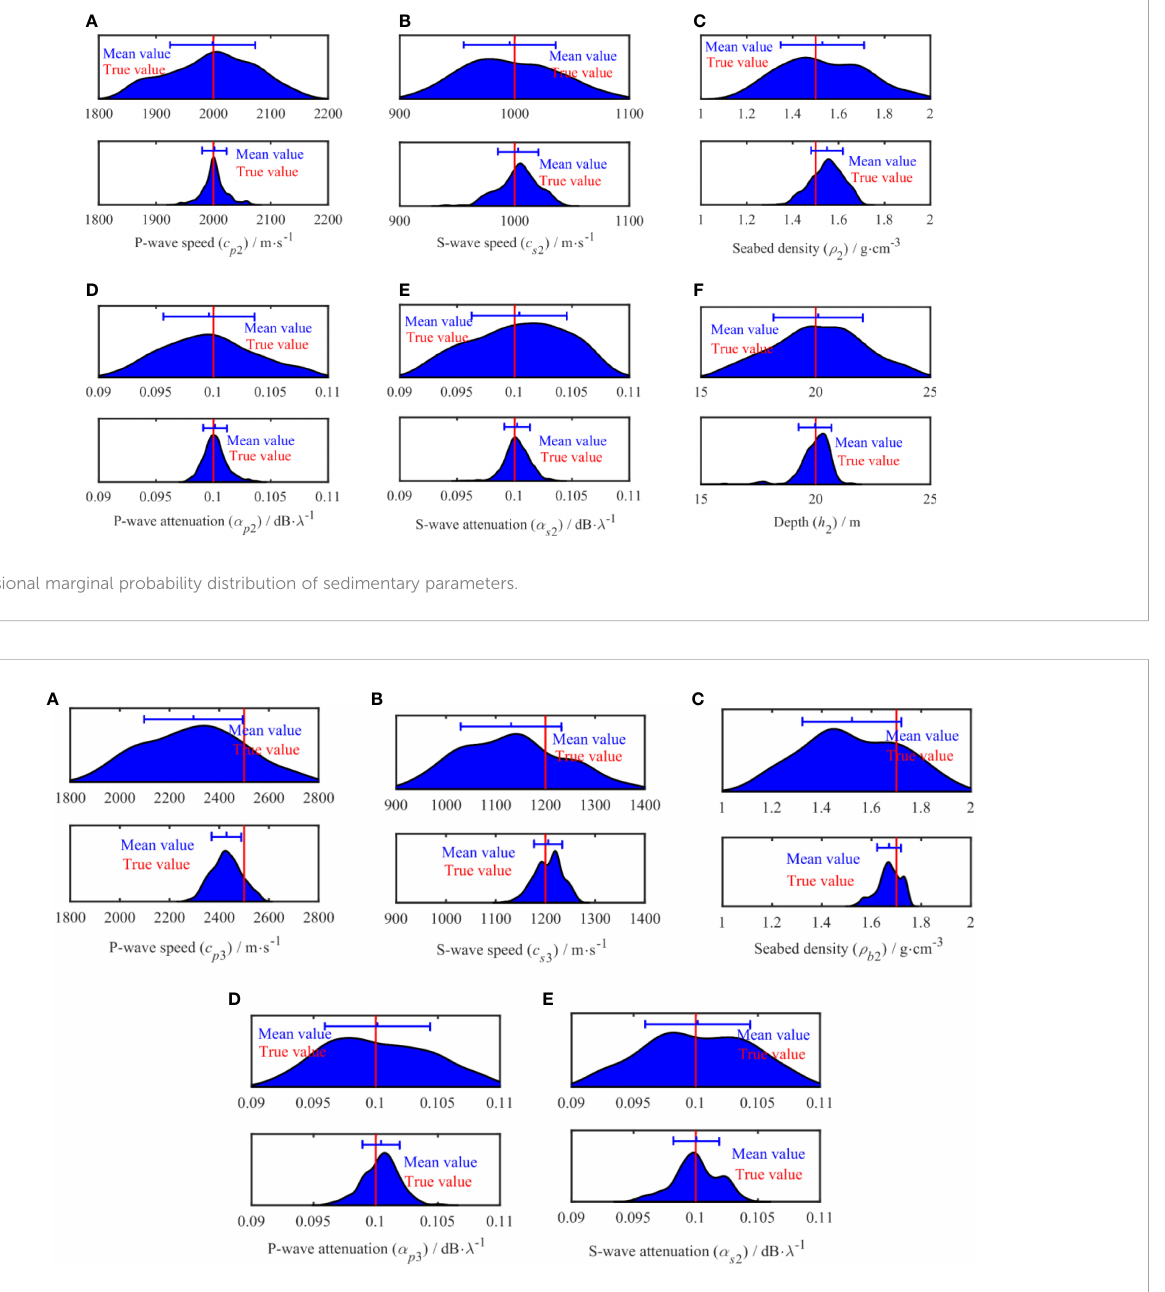
FIGURE 7 One-dimensional marginal probability distribution of semi-in fi nite